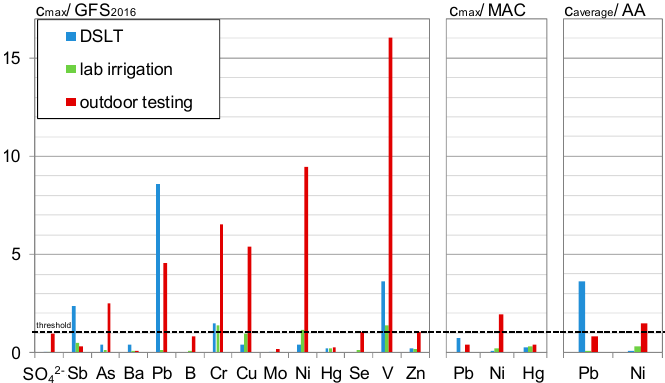
Figure 23. Maximum leachate concentrations related to the de-minimis thresholds after [41] and [6].